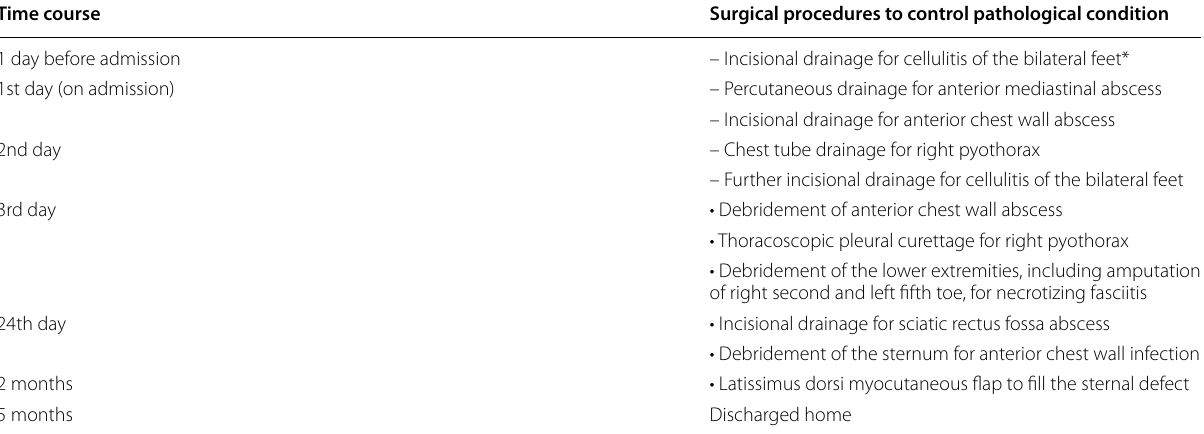
Bullets indicate surgical procedures under general anesthesia. Asterisk means that the procedure was performed at another hospital